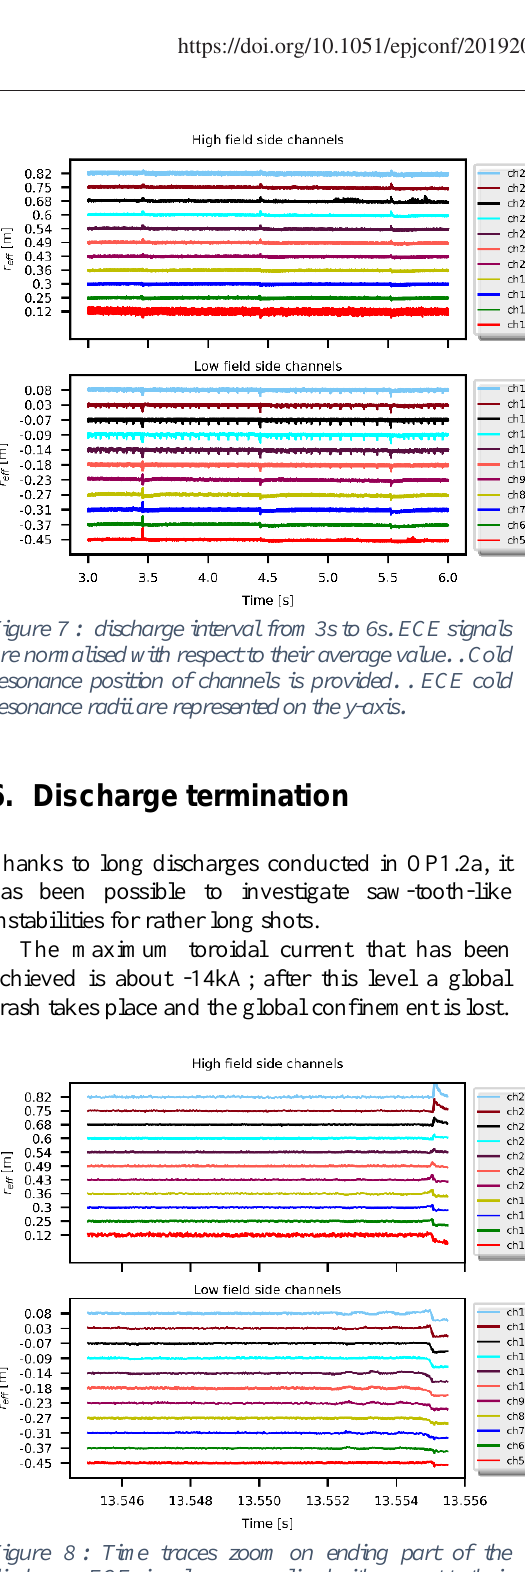
Figure 6 : discharge interval from 0s to 3s. ECE signals are normalised with respect to their average value. Cold resonance position of channels is provided. ECE cold resonance radii are represented on the y-axis